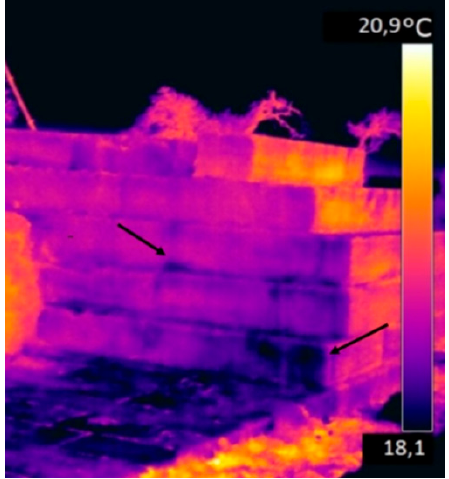
Figure 34. Detection of areas where mosses were macroscopically observed.